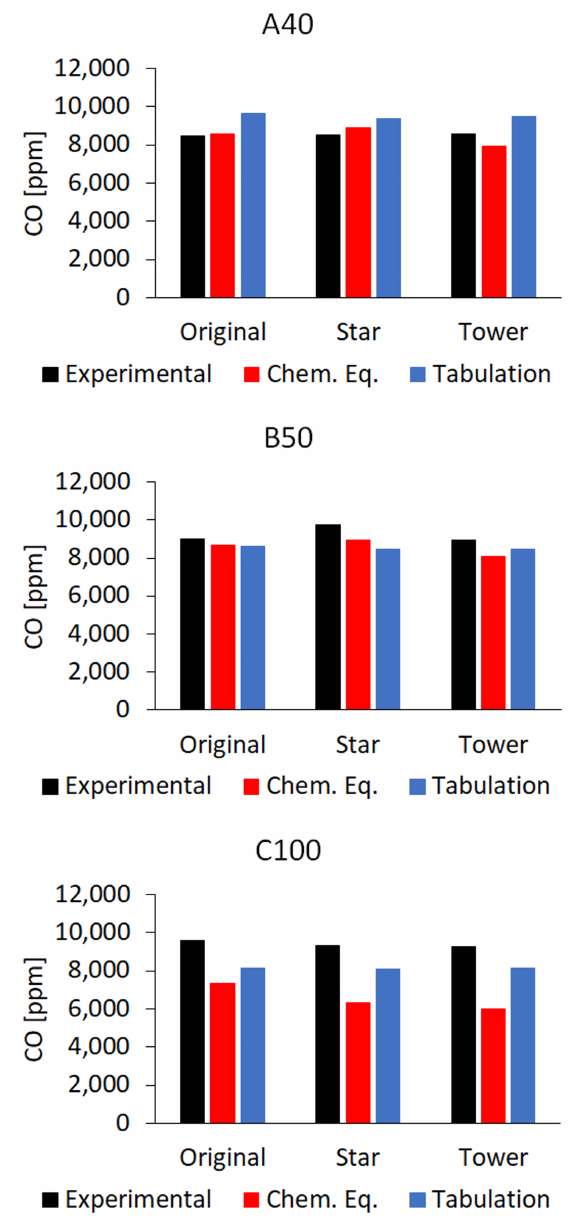
Figure 21. Comparison between the computed and experimental CO emissions for the three investi- gated operating